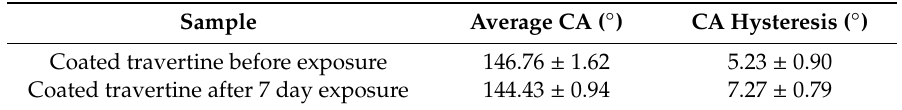
Table 8. The water static contact angle and hysteresis on the travertine coated with TEOS / O 8 TES films before and after outdoor